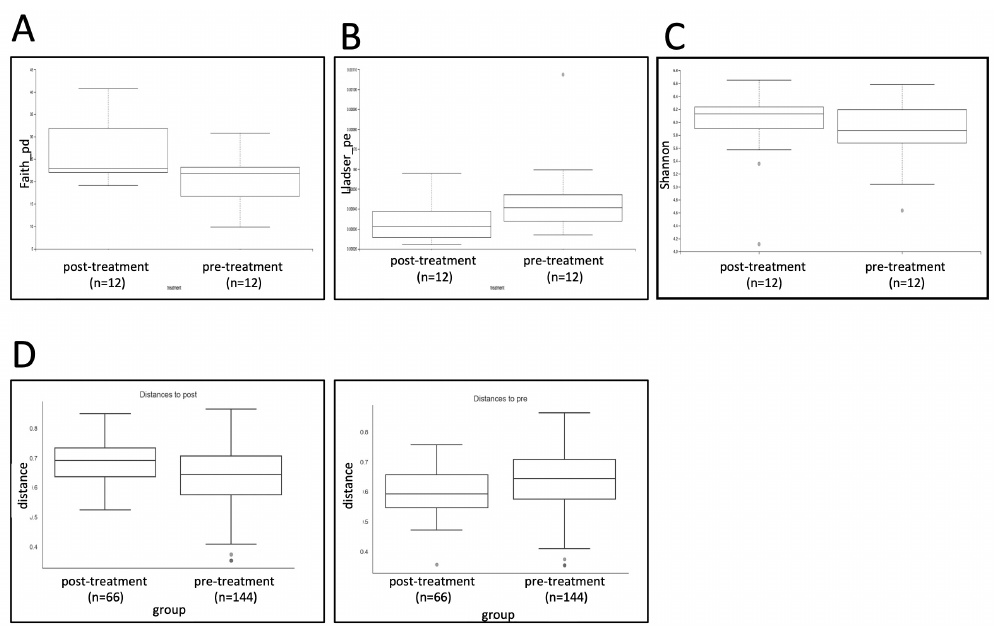
Figure 5. ( A ) Faith’s_pd measure of alpha diversity ( p < 0.1). ( B ) Lladser_pe measure of alpha diversity ( p < 0.1). ( C ) Shannon measure of alpha diversity ( p = NS). ( D ) Unweighted UniFrac measure of beta diversity ( p = NS).